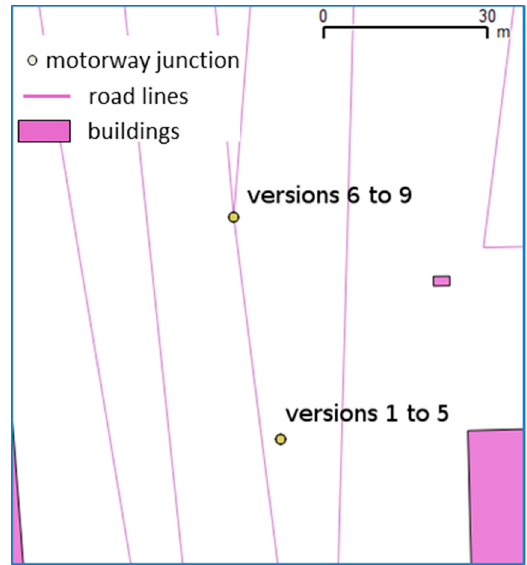
Figure 16. The motorway junction is displaced at the intersection of the motorway and the ramp at version 6, where the displacement is large, i.e., greater than 30 m (©OpenStreetMap contributors).